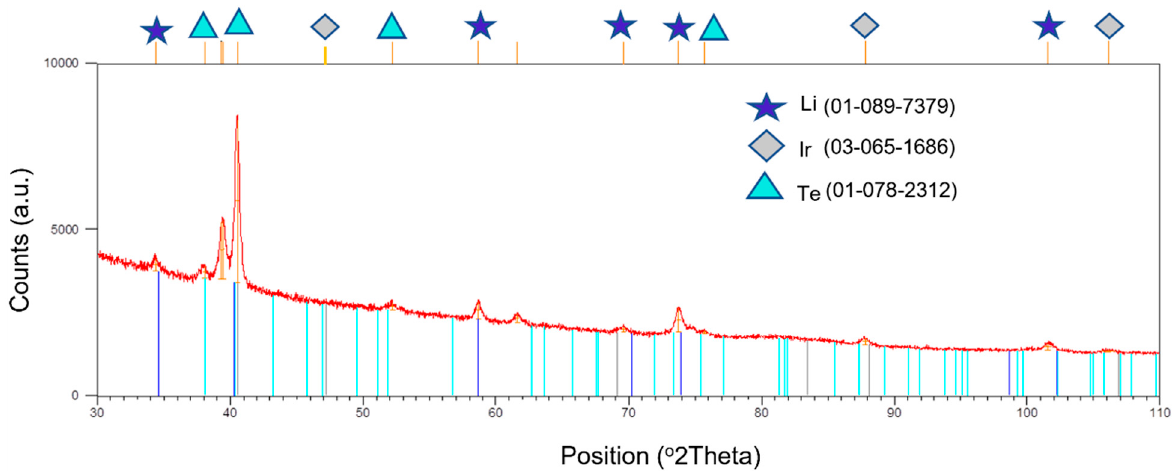
Figure 7. XRD pattern of the washed tellurium-coated iridium substrate/wire.